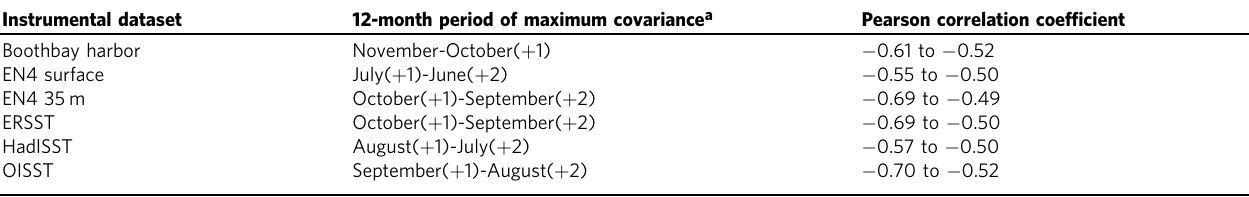
Table 1 Correlations between the oxygen isotope record and available observational records from 1983 to